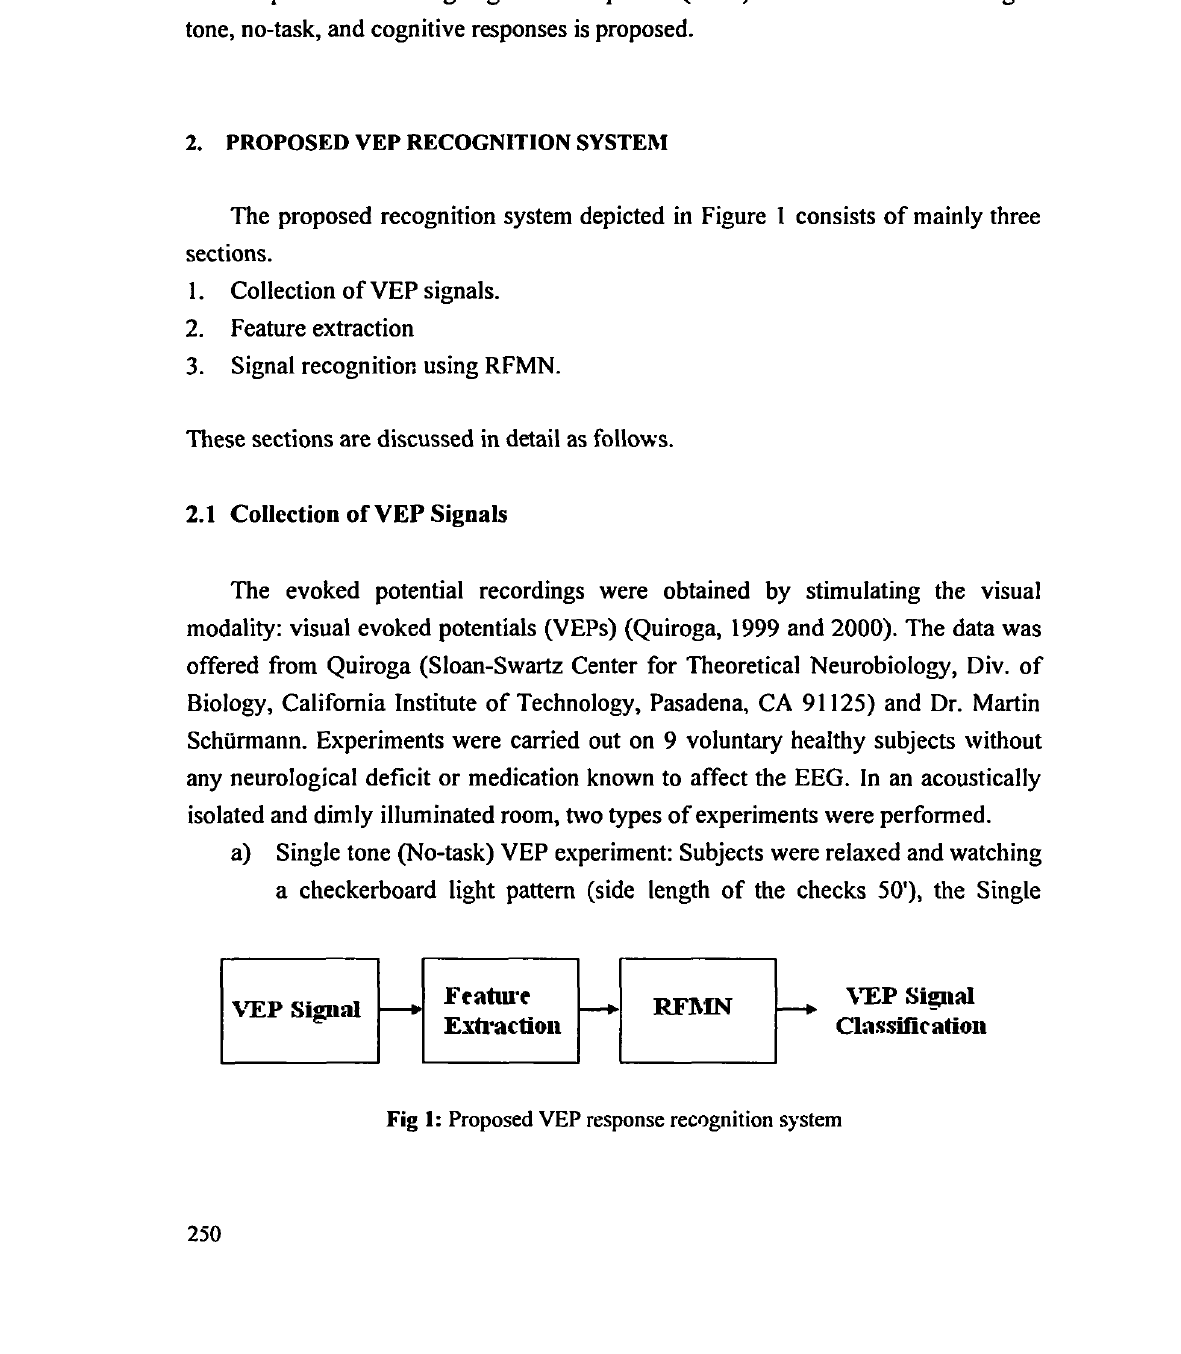
Fig 1: Proposed VEP response recognition